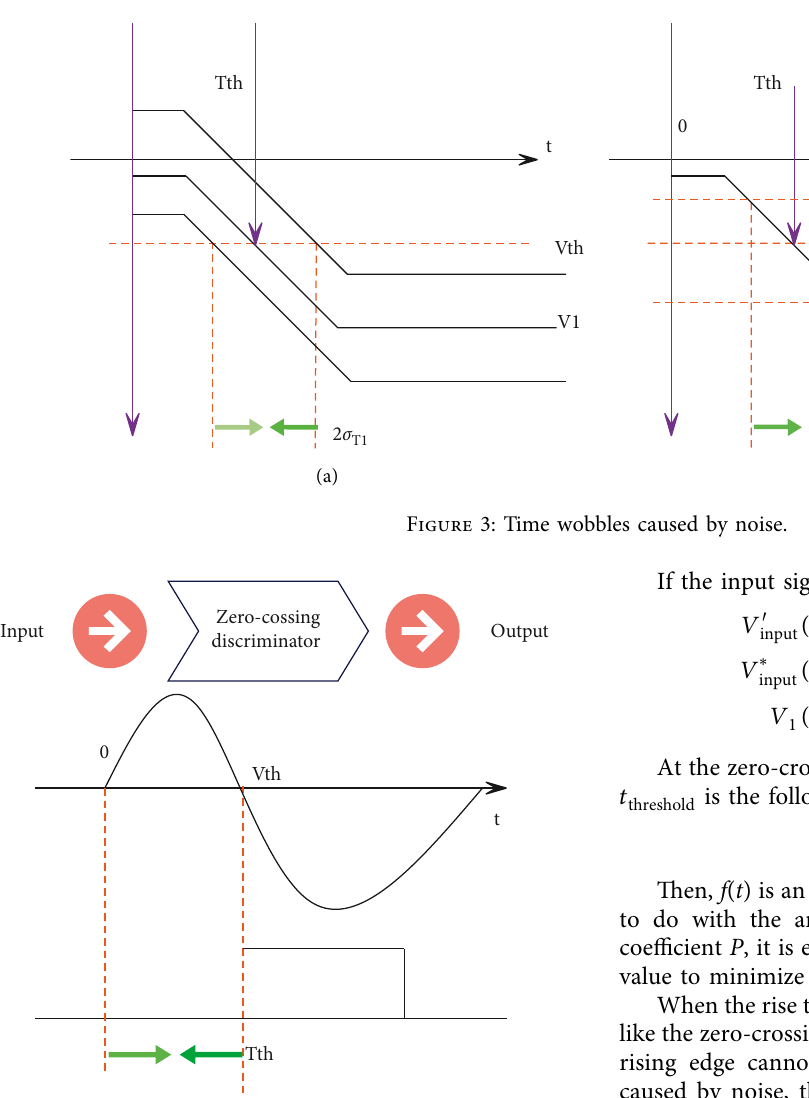
Figure 4: Schematic diagram of zero-crossing timing.